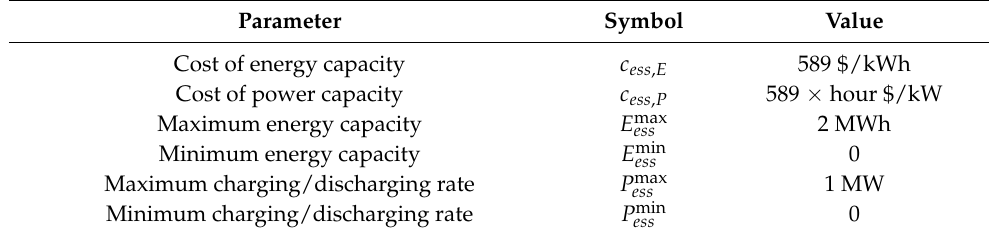
Table 4. Parameters of the ESS.